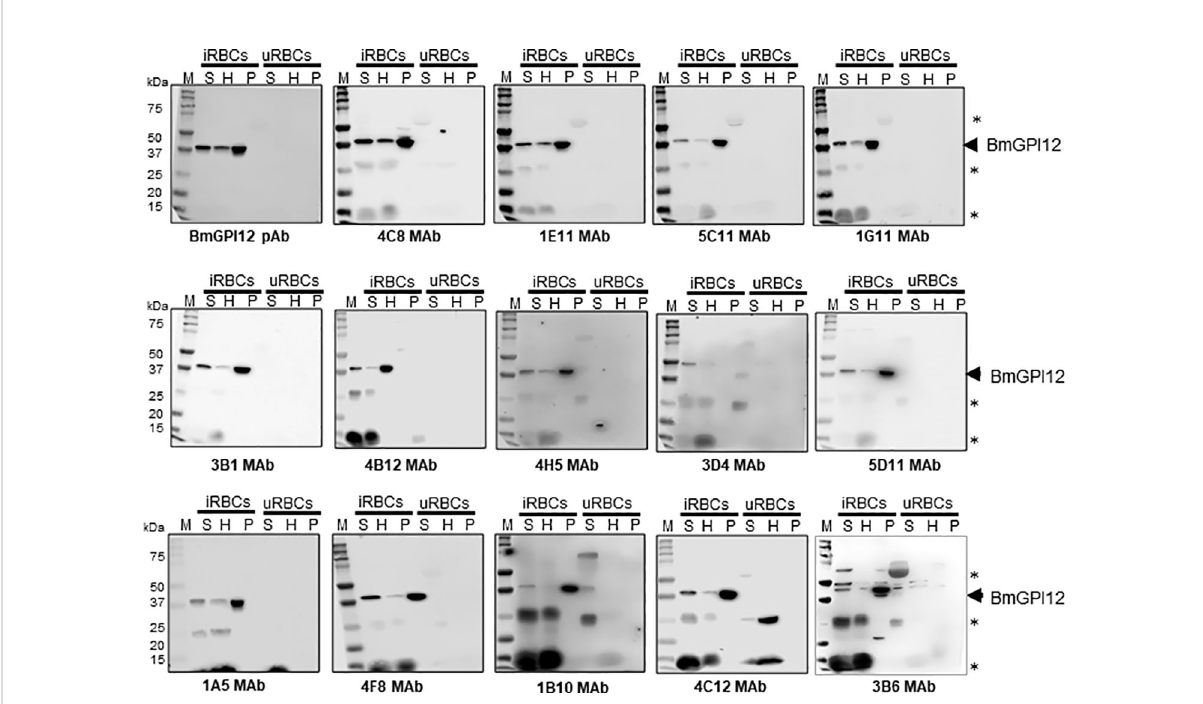
FIGURE 1 Detection and localization of BmGPI12 using anti-BmGPI12 polyclonal and monoclonal antibodies. Immunoblot analysis of secreted (S), hemolysate (H) and parasite (P) fractions isolated from B microti short-term in vitro culture (iRBC) or uninfected human RBCs (uRBCs) using a -BmGPI12 polyclonal (pAb) and different monoclonal antibodies (MAbs). Samples were analyzed on a 12% mini protein gel, transferred to nitrocellulose membrane and probed with BmGPI12 poly or monoclonal antibodies as indicated. * indicates nonspeci fi c bands or degradation